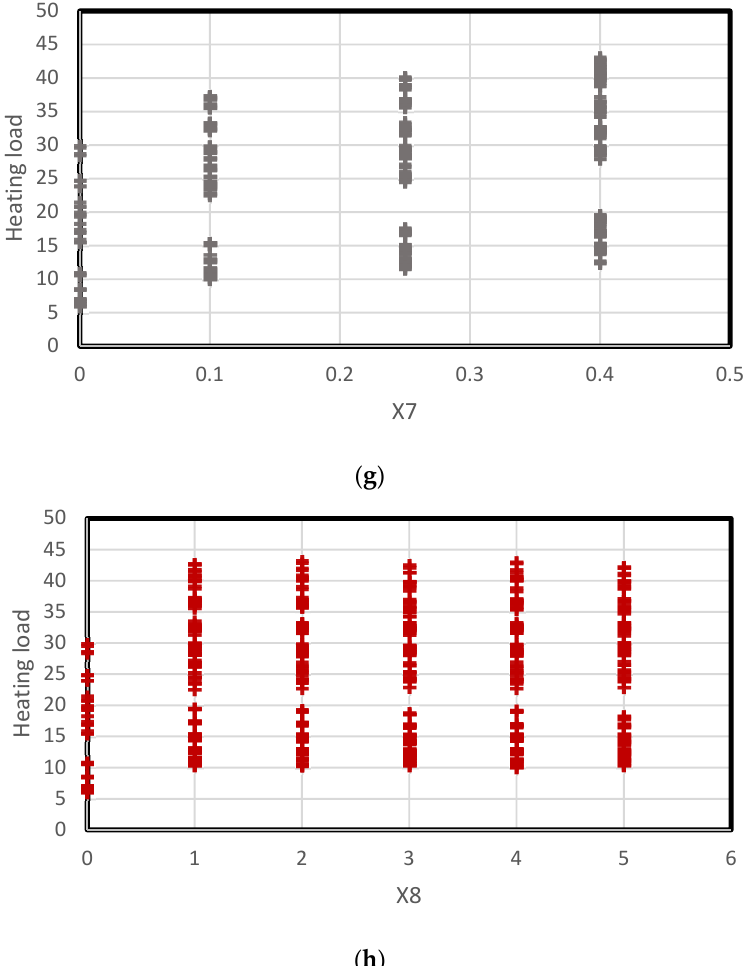
Figure 1. Box plot of used dataset variations with the heating load. ( a ) Relative compactness (RC), ( b ) surface area, ( c ) wall area, ( d ) roof area, ( e ) overall height, ( f ) orientation, ( g ) glazing area, ( h ) glazing area distribution, with the heating load.